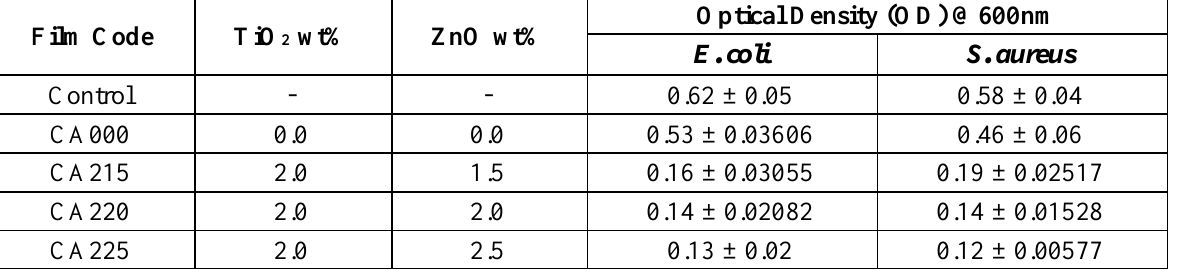
Table 1. Effect of CA and CA/TiO 2 /ZnO in E. coli and S. aureus growth